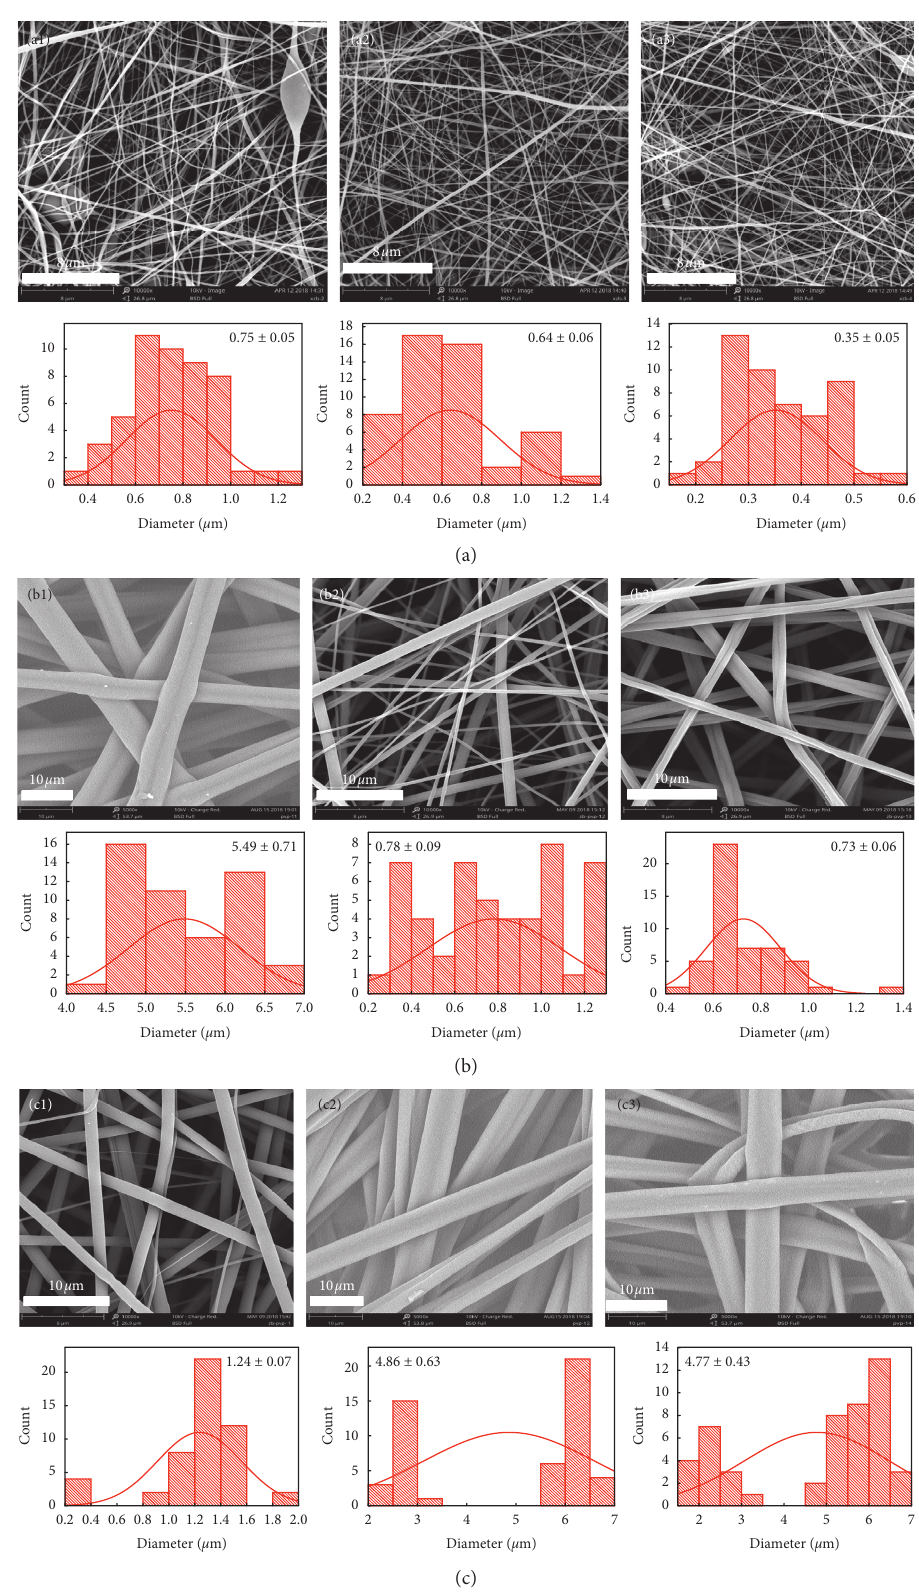
Figure 3: SEM images of electrospun PVP fibers onto different substrates: (a) aluminium foil, (b) wood pulp paper, and (c) silicon paper at different electrospinning voltages of 11 kV (a1, b1, c1), 12kV (a2, b2, c2), and 13kV (a3, b3, c3). The inset images showed the average diameters of the as-spun fibers and their